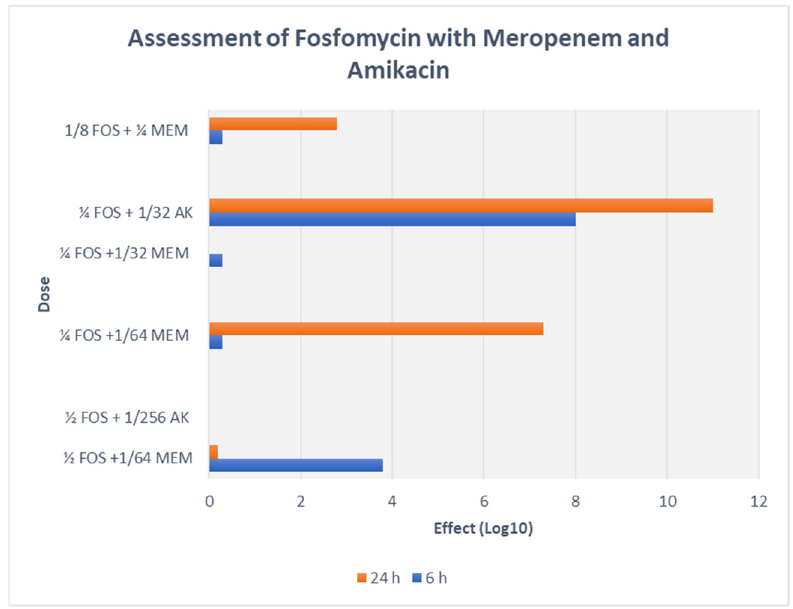
Figure 2. TKA assessment of FOS-MEM and FOS-AK combination with representative strain (Kp5)